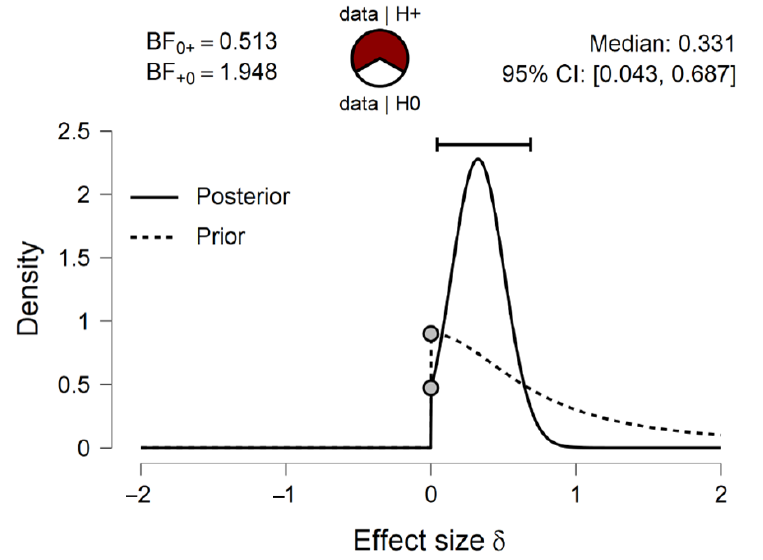
Figure 4. The prior and posterior distribution of the effect size with BF0+ and BF+0, median and 95% Credible Interval (CI) for one-sample one-tailed Bayesian Wilcoxon signed rank test (10,000 samples) on general accuracy score’s difference from chance level (0.5). The distributions indicate that the effect size d is more likely to be larger than 0 under posterior than prior.